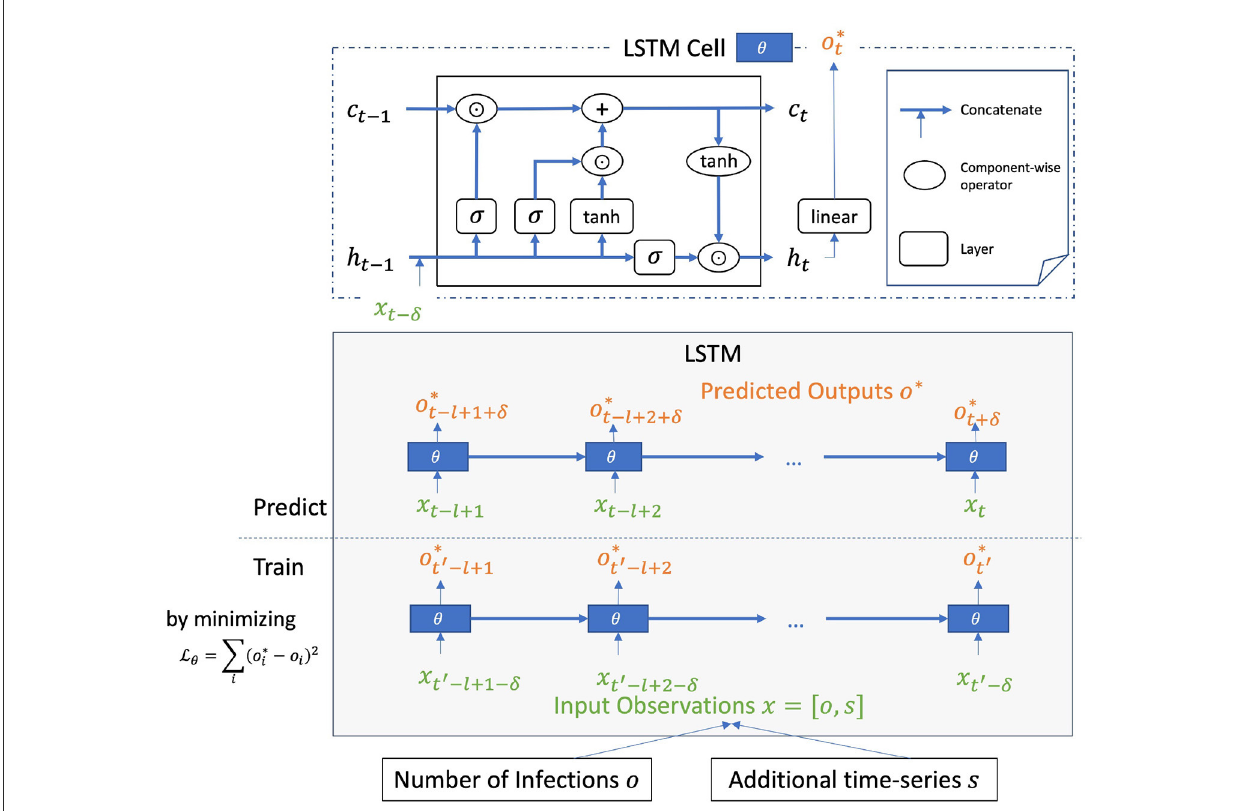
FIGURE3 LSTM model for COVID-19 case prediction with time lag δ configured to work on memory length of l . In inference step, with input sequence { x t − l + 1 ,..., x t } of length l , the model predicts the number of COVID-19 cases o ∗ t + δ , i.e., at δ time steps since the last input time step. Additional time-series s is for one of the emoji features (tweet count or anomalous